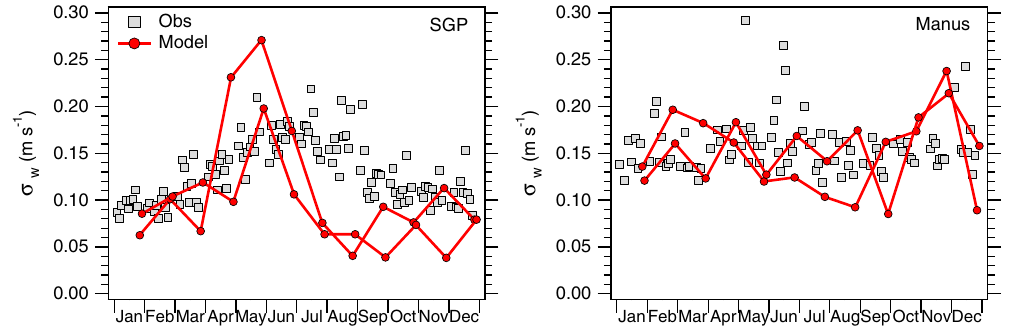
Figure 3. Monthly mean standard deviation in vertical velocity (m s − 1 ) at the SGP and Manus sites calculated from 7 km global output (model) and from radar retrievals (obs). Error bars have been omitted for clarity however the standard error in the observations 13 is about 0.15 m s − 1